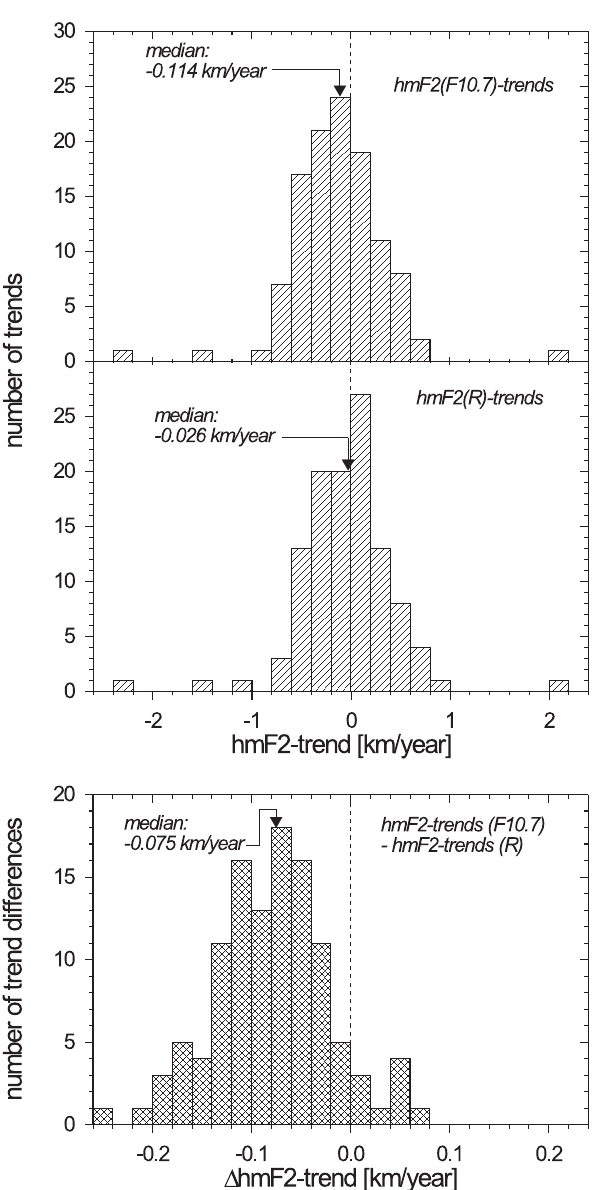
Fig. 4. Histograms of hm F2 trends by use of F10.7 or R data in the trend analyses (upper part) as well as a histogram of the differences of both hm F2 trends (lower part). The corresponding median values are marked by arrows.